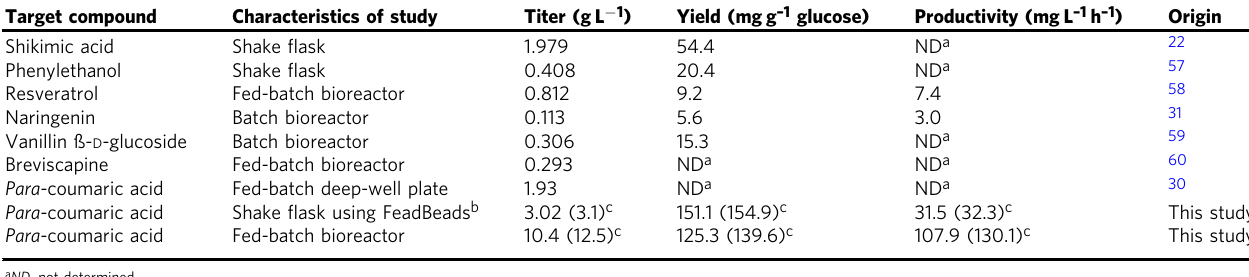
Table 1 Comparison of yeast cell factories for production of aromatic chemicals Target